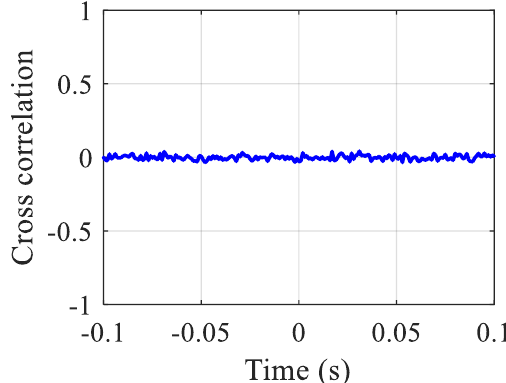
Figure 4. The BCC result of the simulated sensor signals for the pipe without leakage.